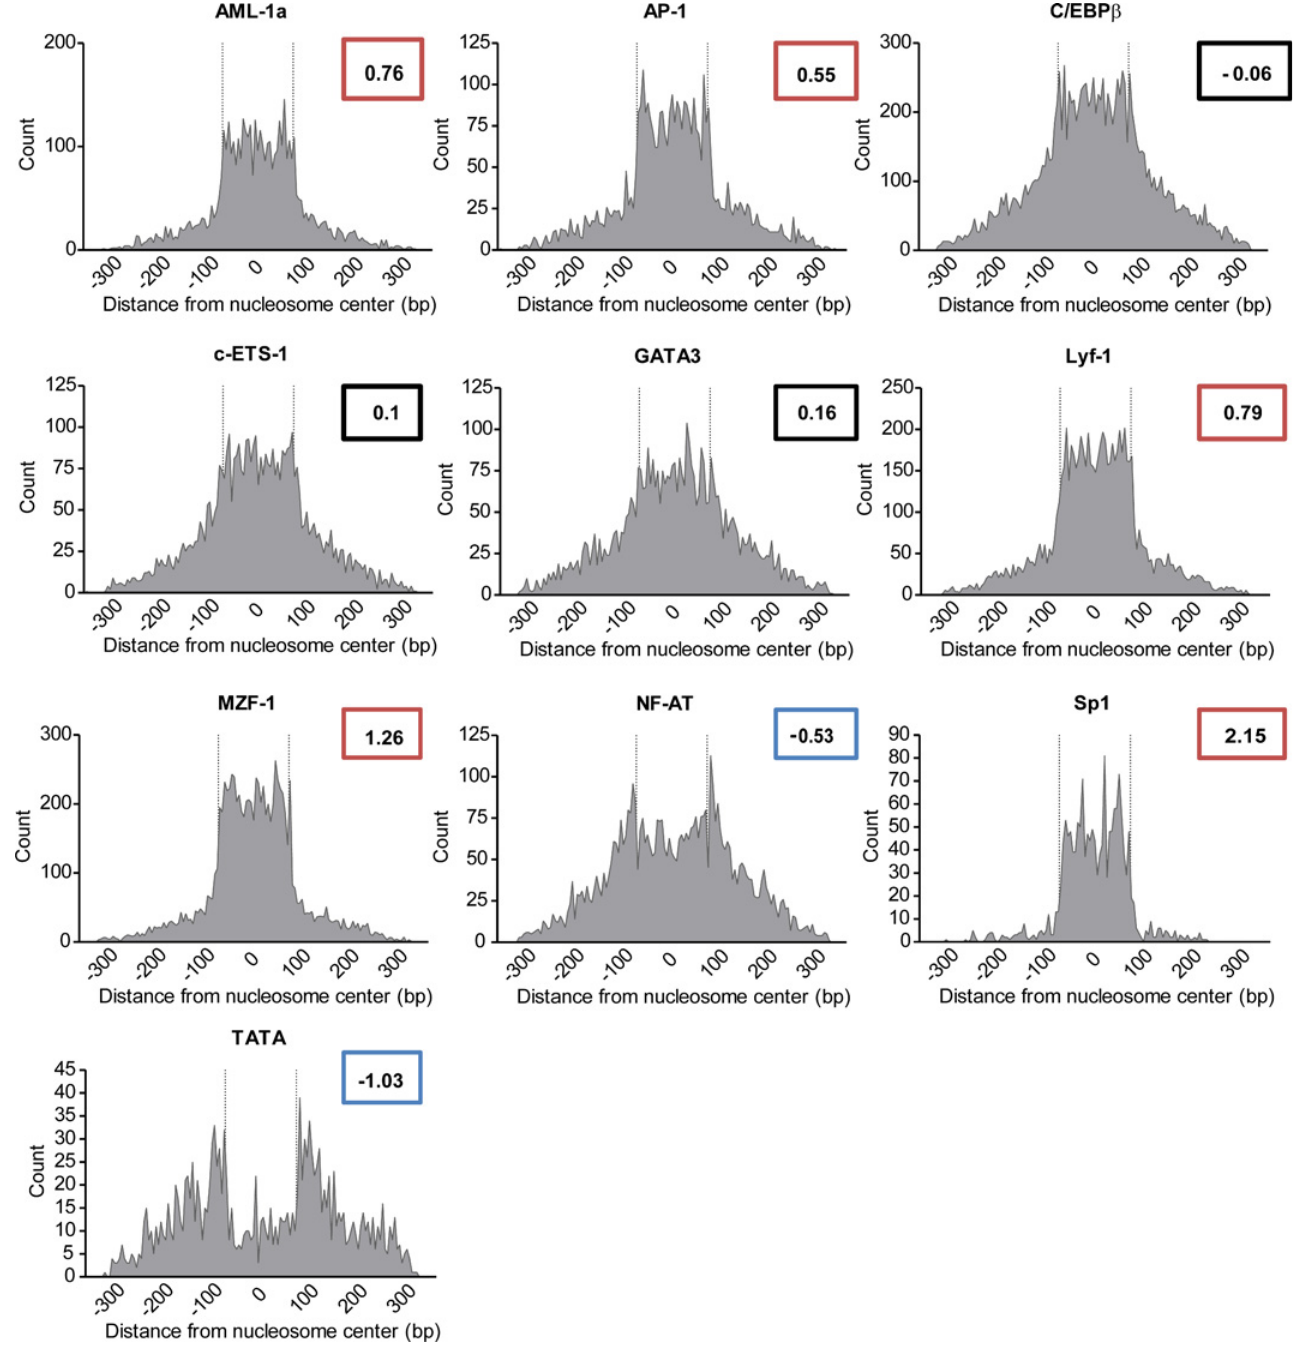
Fig 2. Proximity of transcription factor binding sites to predicted nucleosome centers within the Ly49 gene family. The C57BL/6 nucleosome map as generated in Fig 1 was compared individually to 17 transcription factors drawn from the TRANSFAC or JASPAR databases, plus TATA as a control. For factors with over 300 putative binding sites in the Ly49 gene family, a histogram is shown displaying each factor binding site ’ s distance to the nearest nucleosome. Dashed vertical lines indicate the nucleosome boundary. The kurtosis of each histogram is indicated. Histograms with a kurtosis less than -0.5 (blue) are considered to preferentially avoid nucleosome centers; those with kurtosis over 0.5 (red) are preferentially clustered in the center; and those between -0.5 and 0.5 (black) display no preference for nucleosome